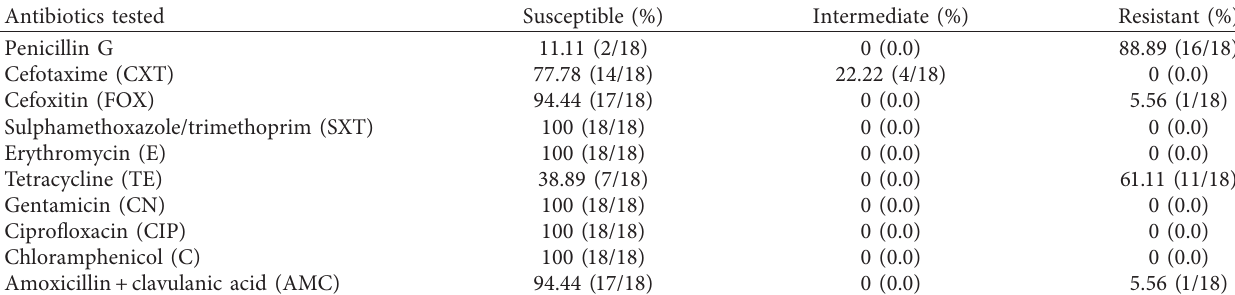
Table 3: Summary result of the antimicrobial sensitivity test ( n � 18) on isolated S . aureus